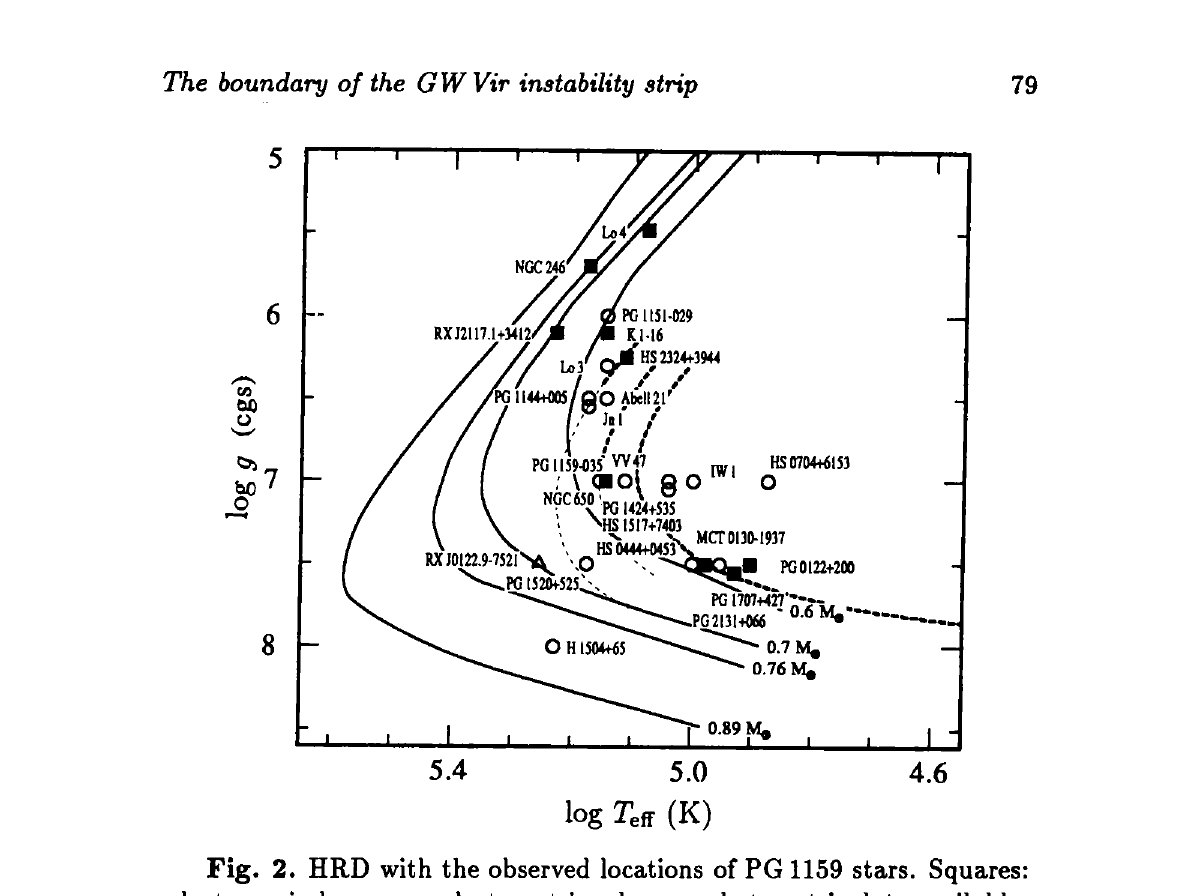
Fig. 2. HRD with the observed locations of PG 1159 stars. Squares: pulsators, circles: non-pulsators, triangles: no photometric data available. Solid lines: post-AGB stellar evolutionary tracks (Wood & Faulkner 1986, He burners, mass-loss type B). Dashed lines: evolutionary tracks which have started from the homogeneous helium main-sequence models with 0.57, 0.63 and 0.70 M© (Gautschy 1997). Thick parts of the latter tracks denote phases where pulsational instability